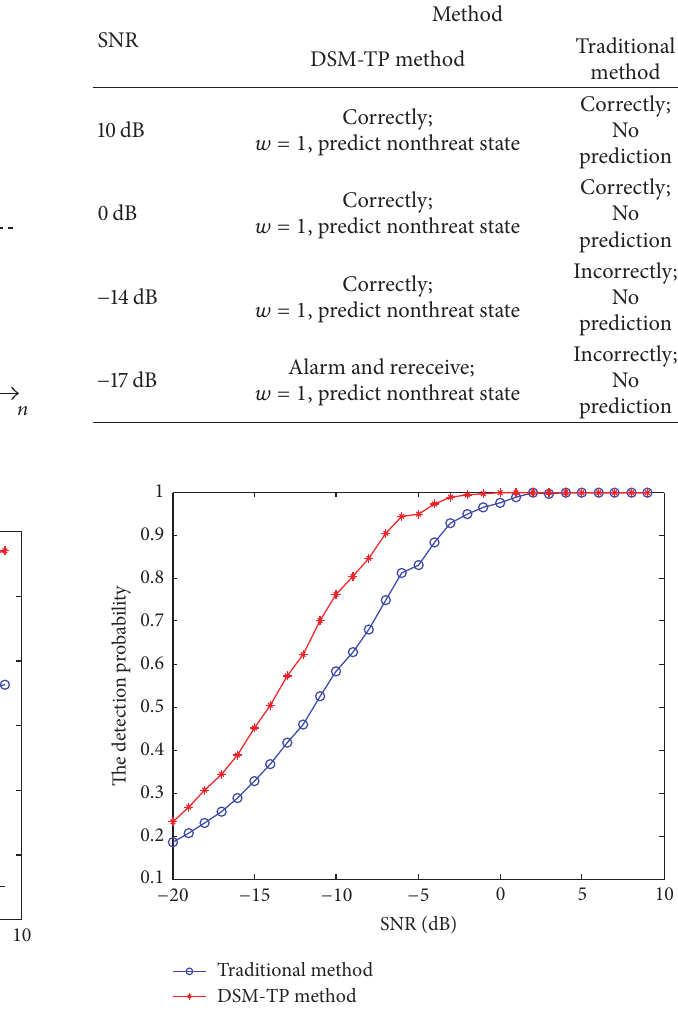
Figure 9: Detection probability for changing